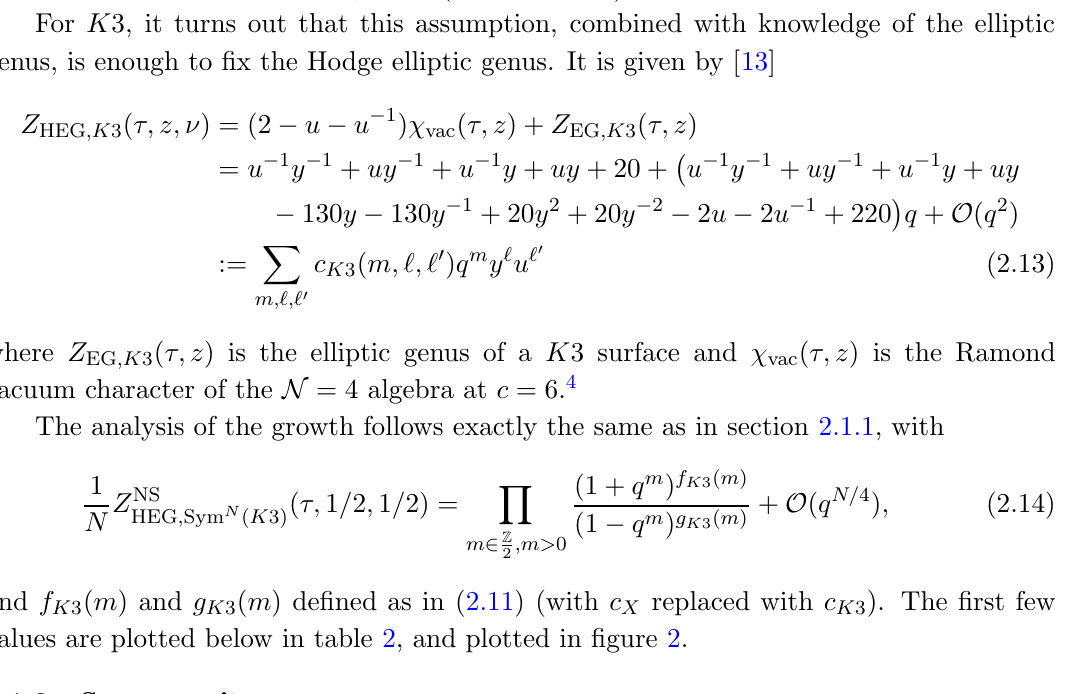
Figure 1 . A plot of log ( f growth in m